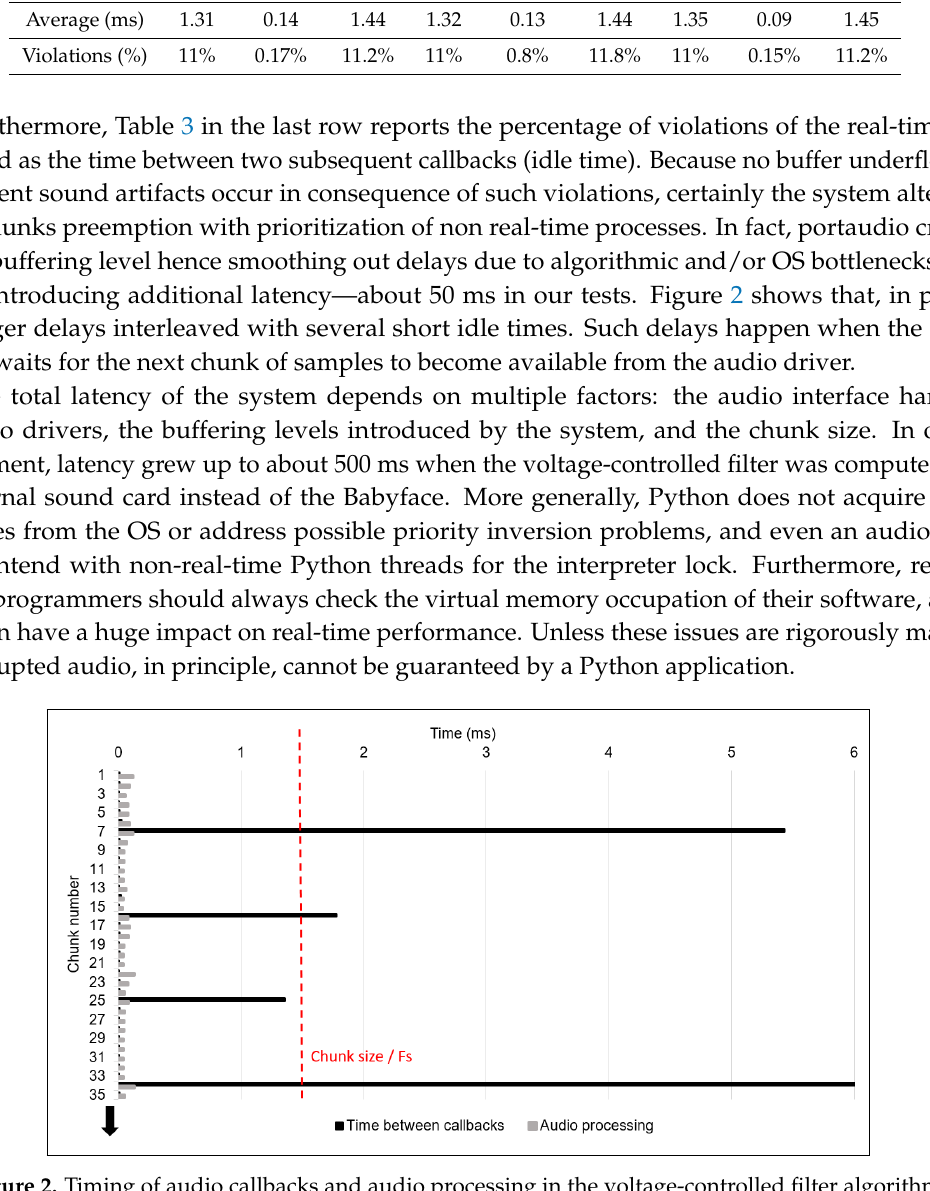
Figure 2. Timing of audio callbacks and audio processing in the voltage-controlled filter